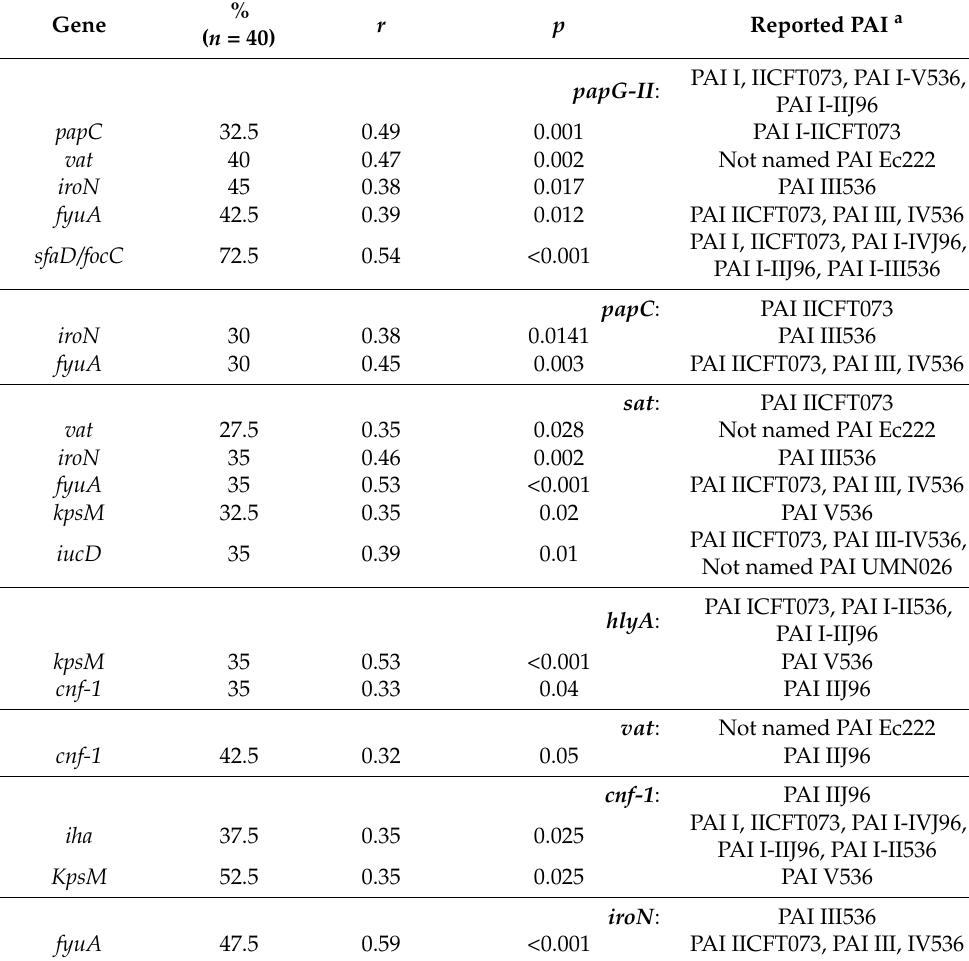
Statistical significance and correlation value ( r ) was obtained with Pearson correlation coefficient. For Pearson correlation test, we statistically analyzed all genotypes, phenotypes, and phylogenetic groups against another; r values were obtained and p value was confirmed with Fisher’s exact test or Chi-square. Correlation is significant at 0.01 level (2-tailed). a : Accession link to Pathogenicity Island Database (PAI DB) E. coli Pathogenicity